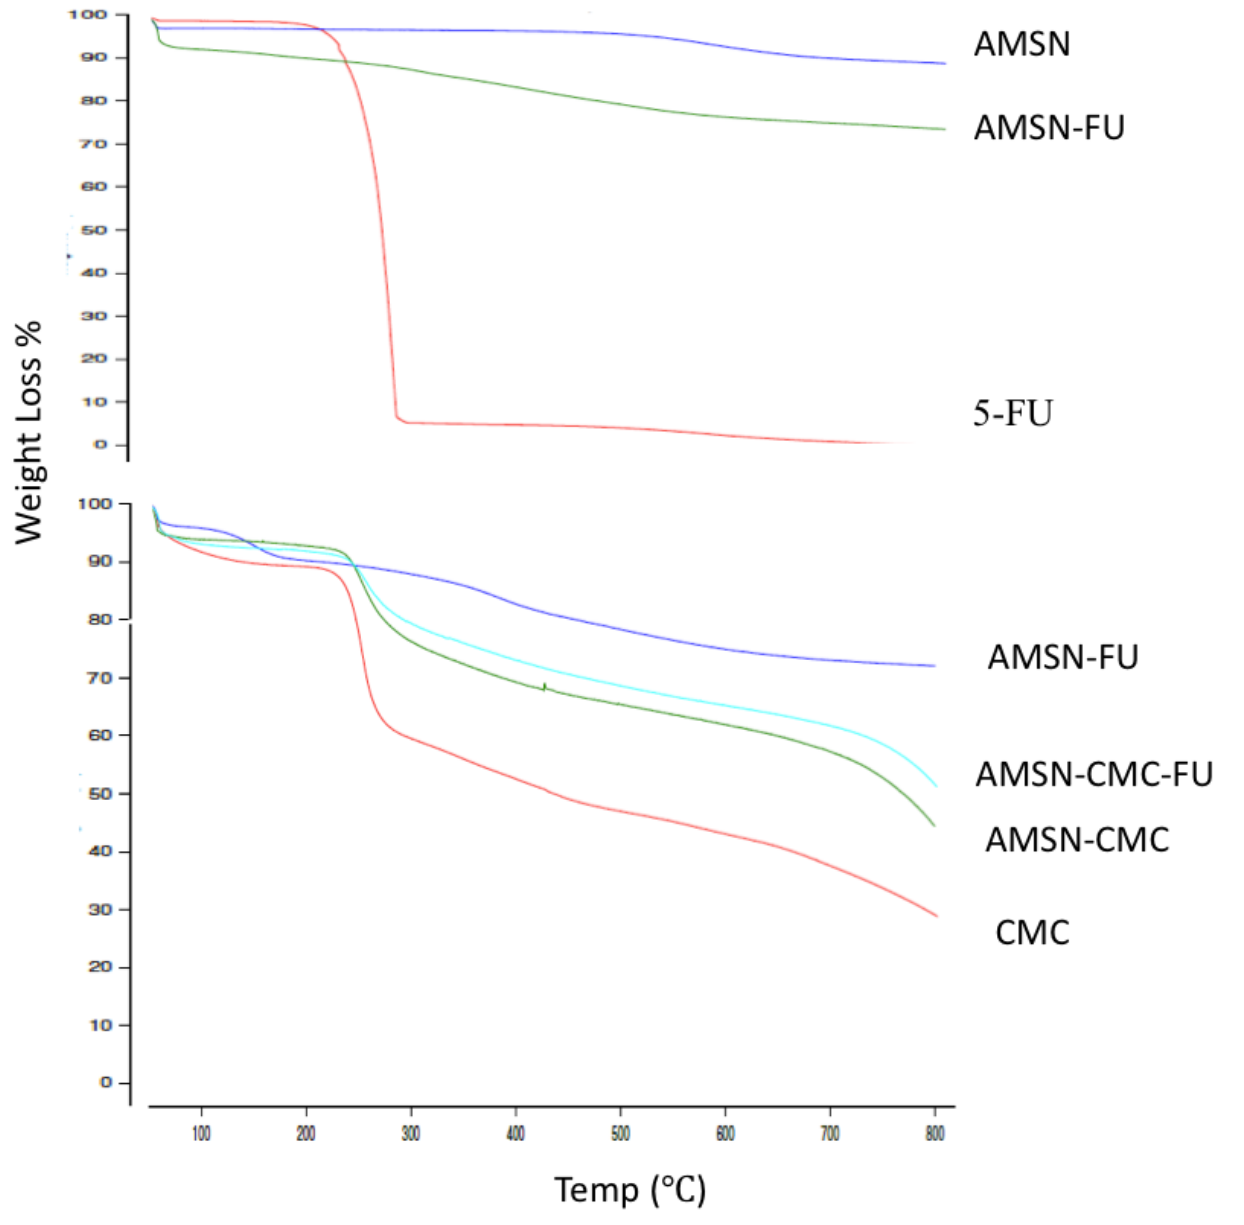
Figure 4. TGA thermograms of (upper figure) 5-FU, AMSN, and AMSN-FU; (lower figure) CMC, AMSN-CMC, AMSN-FU and AMSN-CMC-FU.